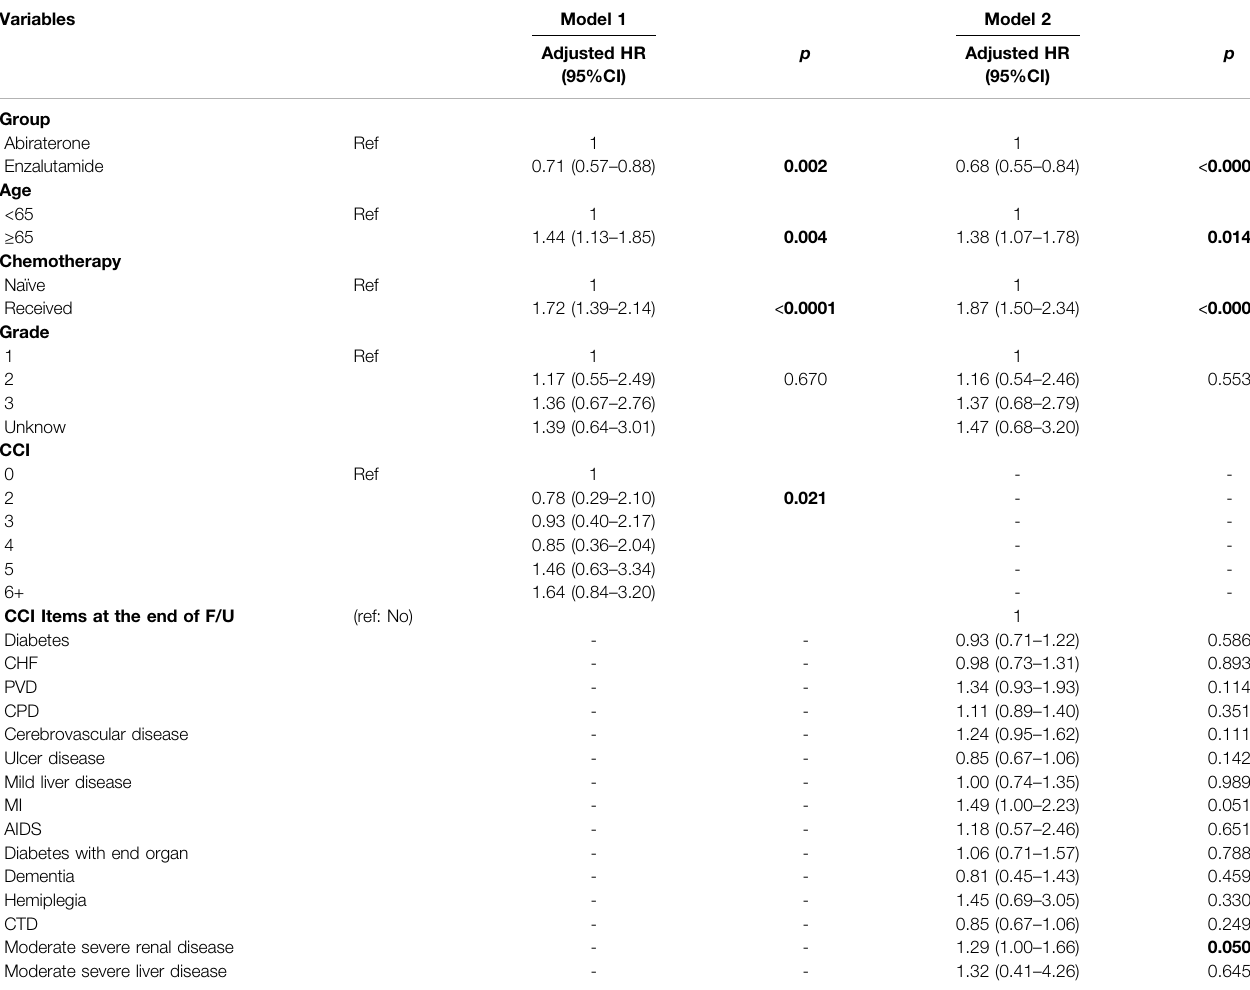
TABLE 3 | Predictors of Overall survival, analyzed by Cox Hazard Ration Regression with model 1(CCI scores) and model 2 (CCI items).